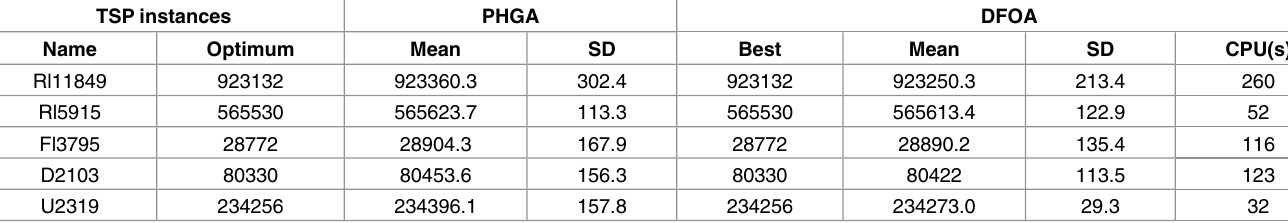
Table 3. Comparison of the DFOA and PHGA on large-scale TSP instances after 20 repetitions. TSP instances